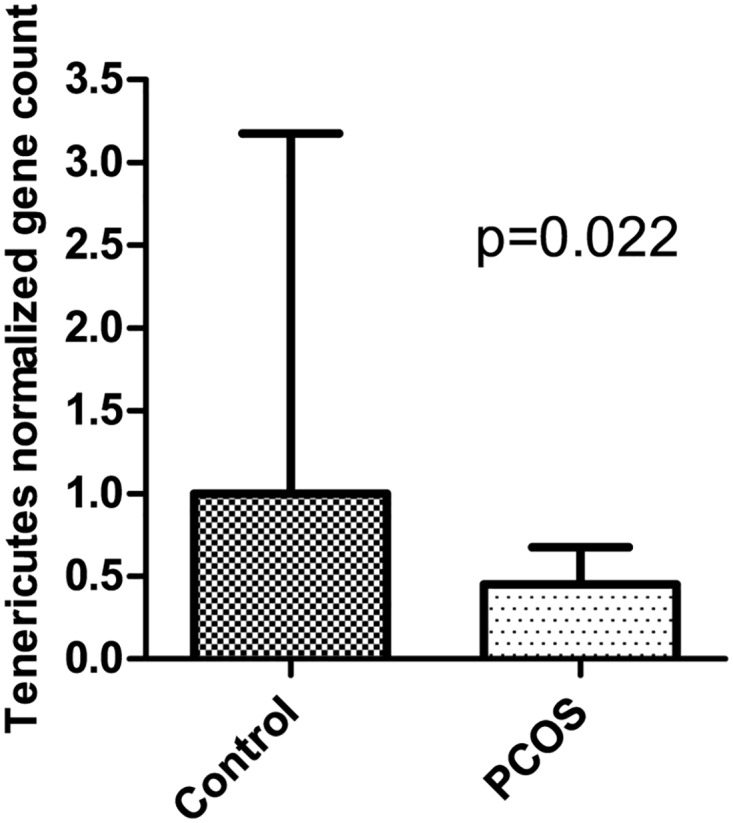
Relative abundance of Tenericutes in fecal samples from PCOS patients and controls assessed by real-time qPCR.Ct values were normalized to total 16S rRNA content. Median and IQR are plotted.